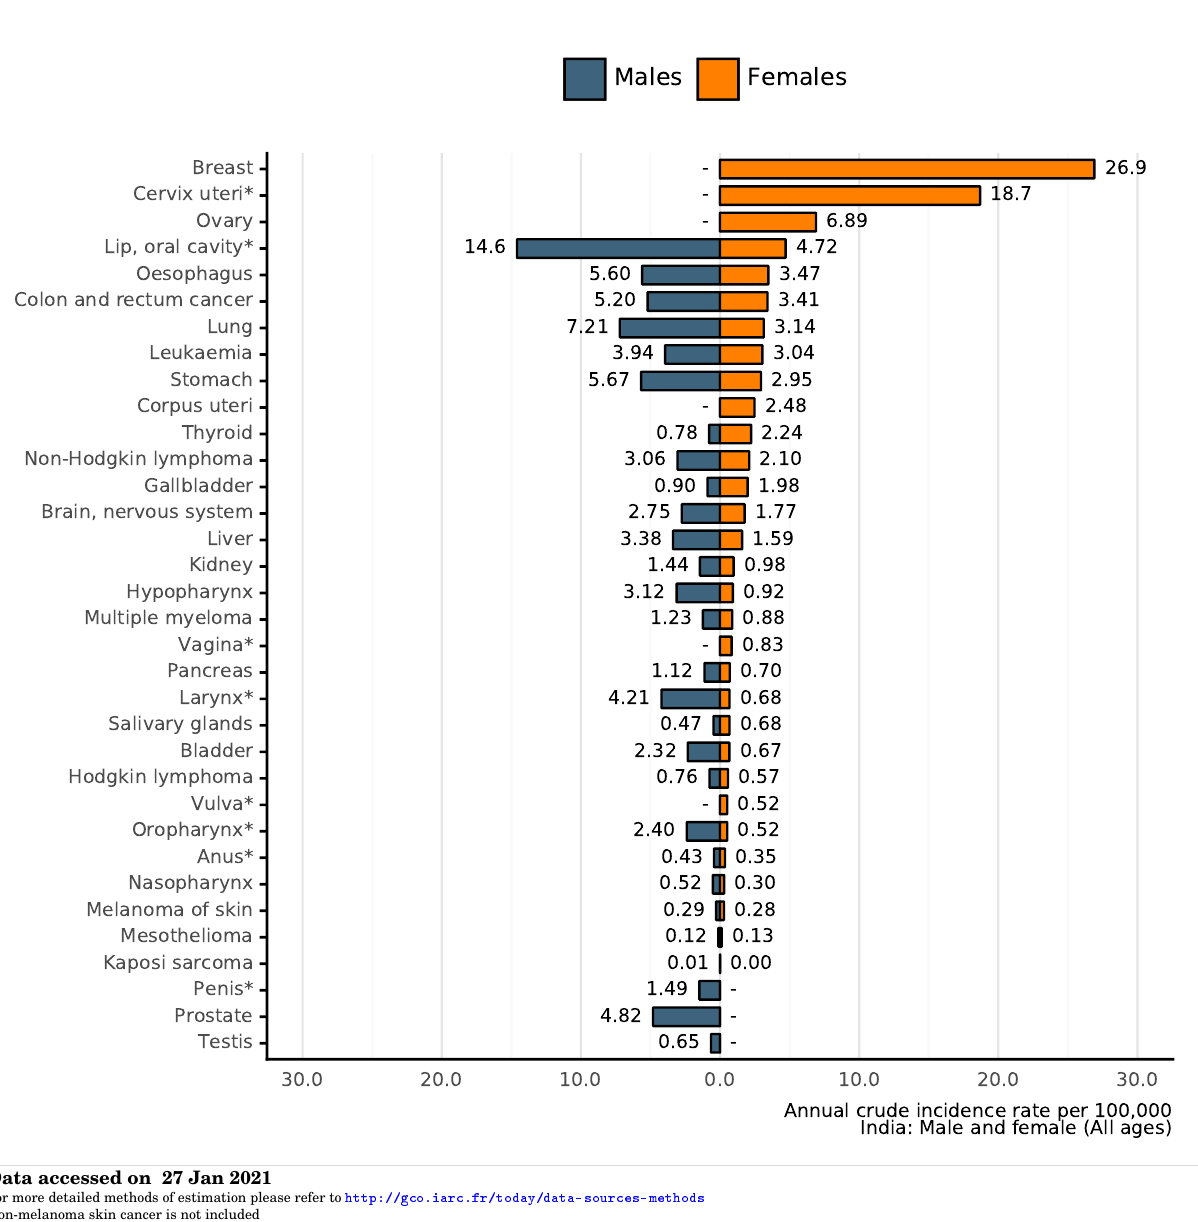
Figure 4: Comparison of HPV related cancers incidence to other cancers in men and women of all ages in India (estimates for